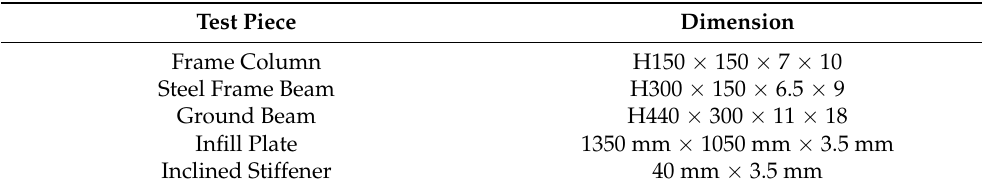
Figure 1. Literal SPSW size. Table 1. The dimension of test